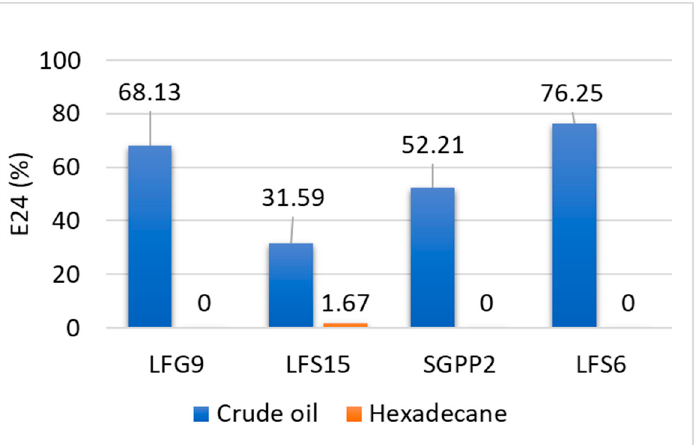
Figure 3. Emulsification index E 24 of bacterial isolates Shinella zoogloeoides LFG9, Bacillus swezeyi LFS15, Pseudomonas guguanensis SGPP2, and Bacillus safensis LFS6 against crude oil and hexadecane.